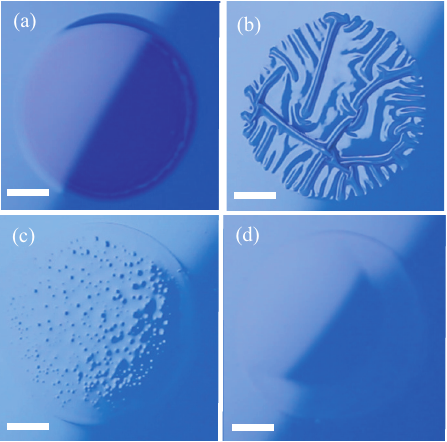
Figure 2. Deformations of layers obtained in experiments for ( a ) T = 1 h, ( b ) 24 h, ( c ) 56 h, and ( d ) 64 h, where T is the time elapsed between the application of the paint layer and the application of the drop of organic solvent. These images were taken at t = 600 s after the application of the organic solvent. Solid lines in the photos are 3.0-mm-scale